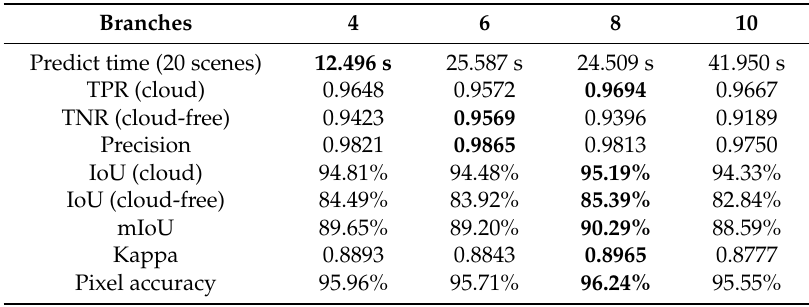
Table 3. Optimization of the number of branches to be used by